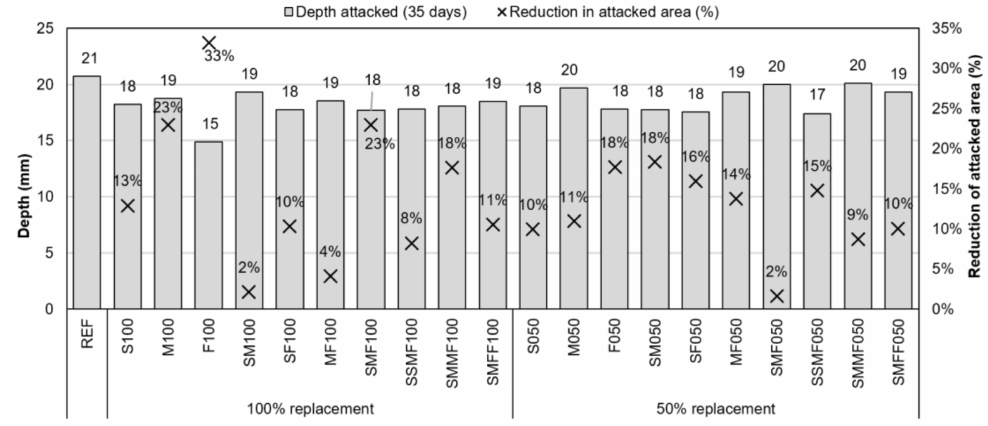
Figure 13. Depth and reduction of the area attacked by chlorides after 35 days of exposition to a 2.8 M NaCl